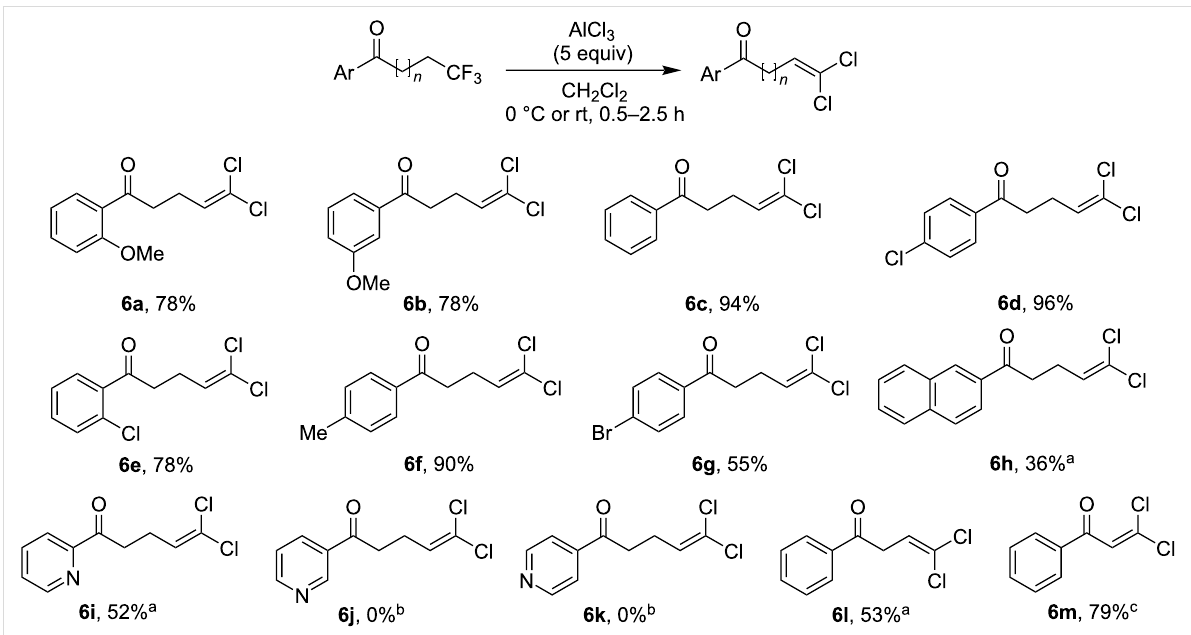
Scheme 2: Substrate scope for the reaction of 1,1,1 trifluoroalkanones with AlCl 3 . a Purification (normal or reversed-phase chromatography) required. b Complex mixture. c 5 Days.